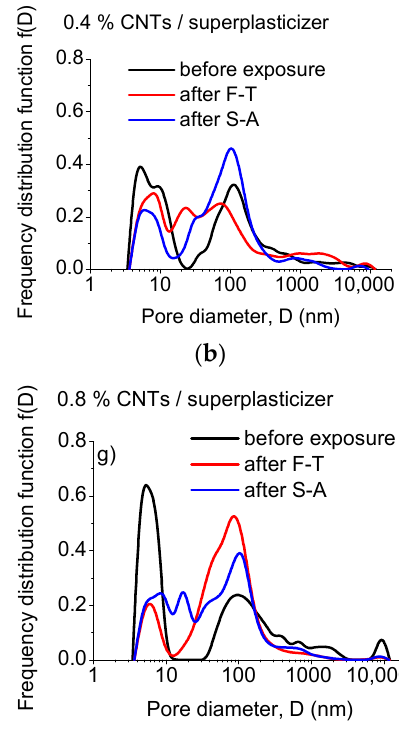
Figure 4. Effect of exposure state on the pore size distribution of un-modified mortars.